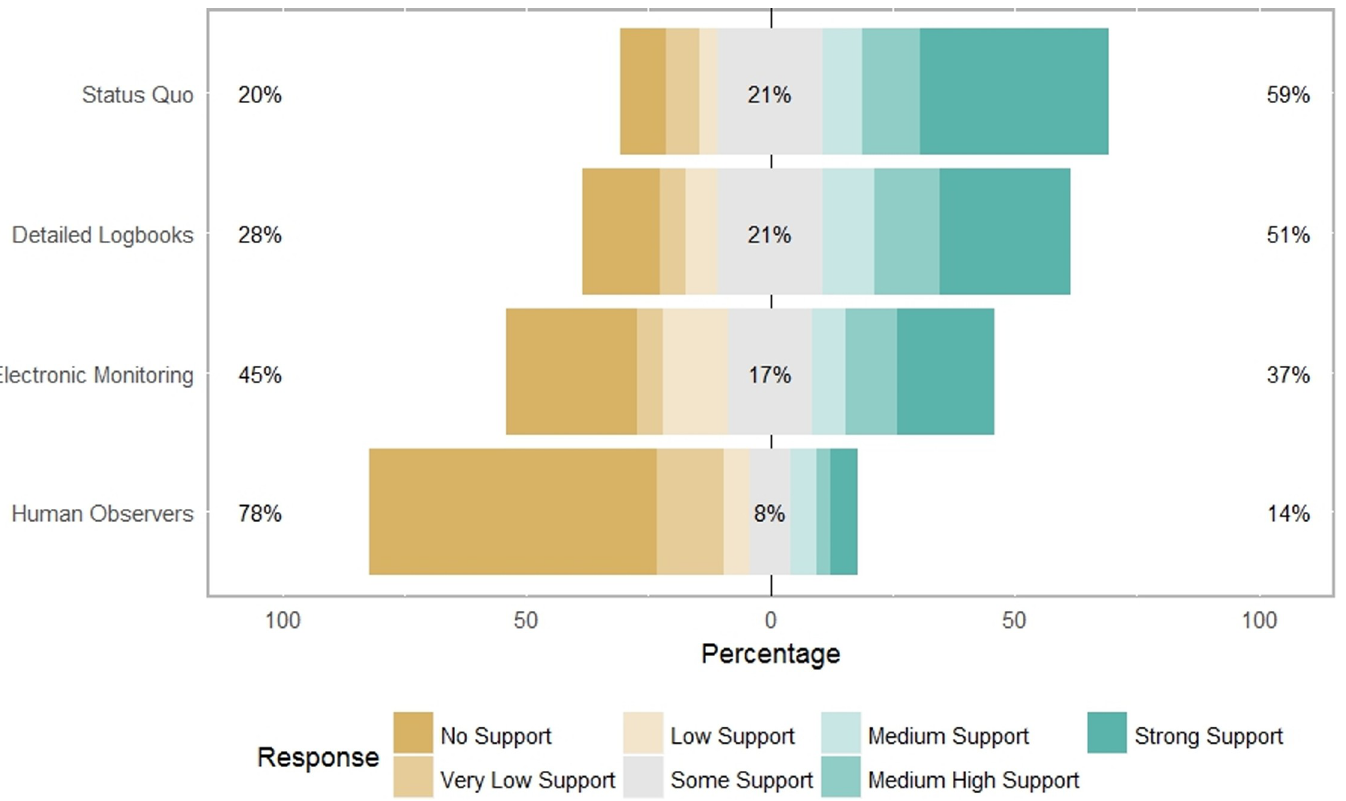
Fig 4. Likert analysis of rankings data across human observers, electronic monitoring, detailed logbooks, and the status quo alternatives for data collection at sea, from semistructured interviews ( n = 75). This graphic was created using the ‘likert’ package in the R software program [53,54].Note not all percentages add to 100, due to